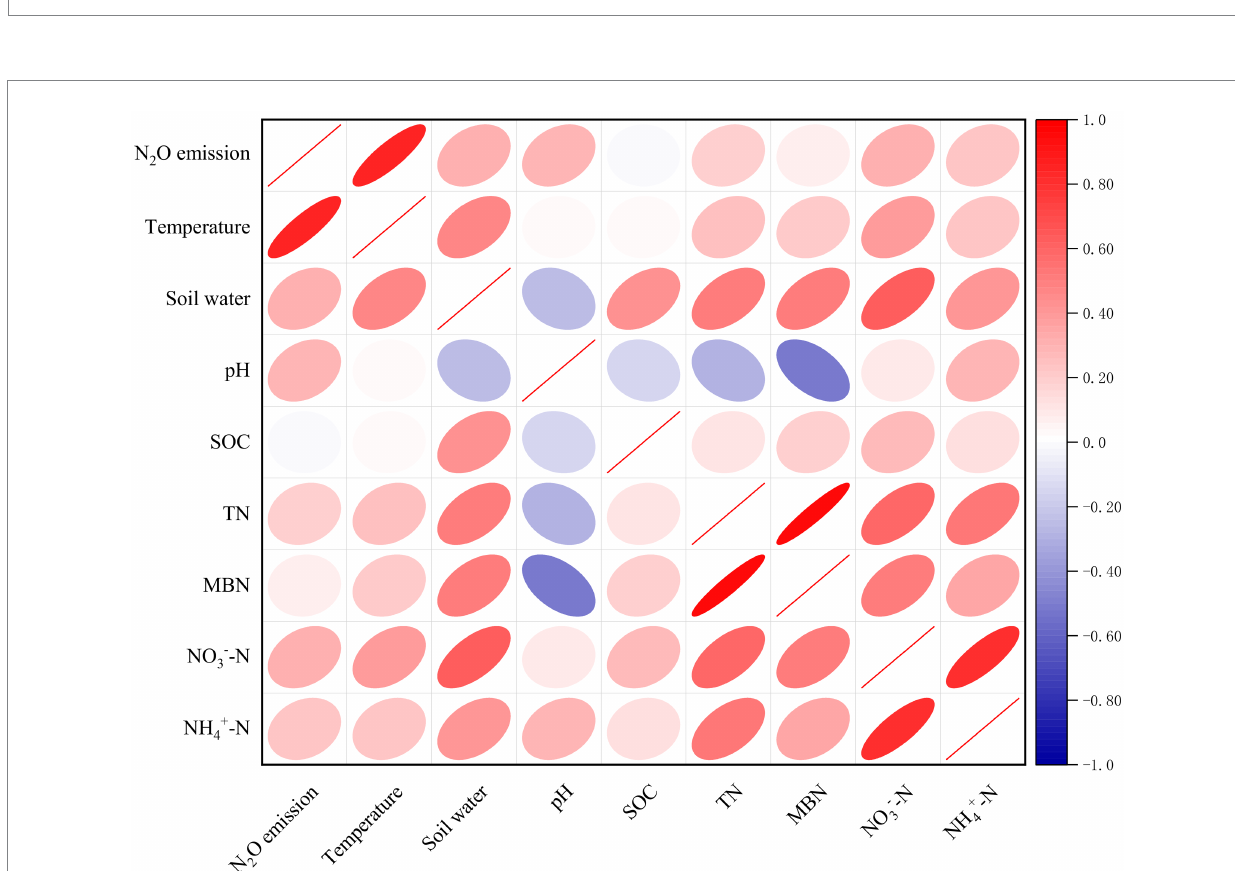
FIGURE 8 Correlation between soil N 2 O emissions and soil properties under land use